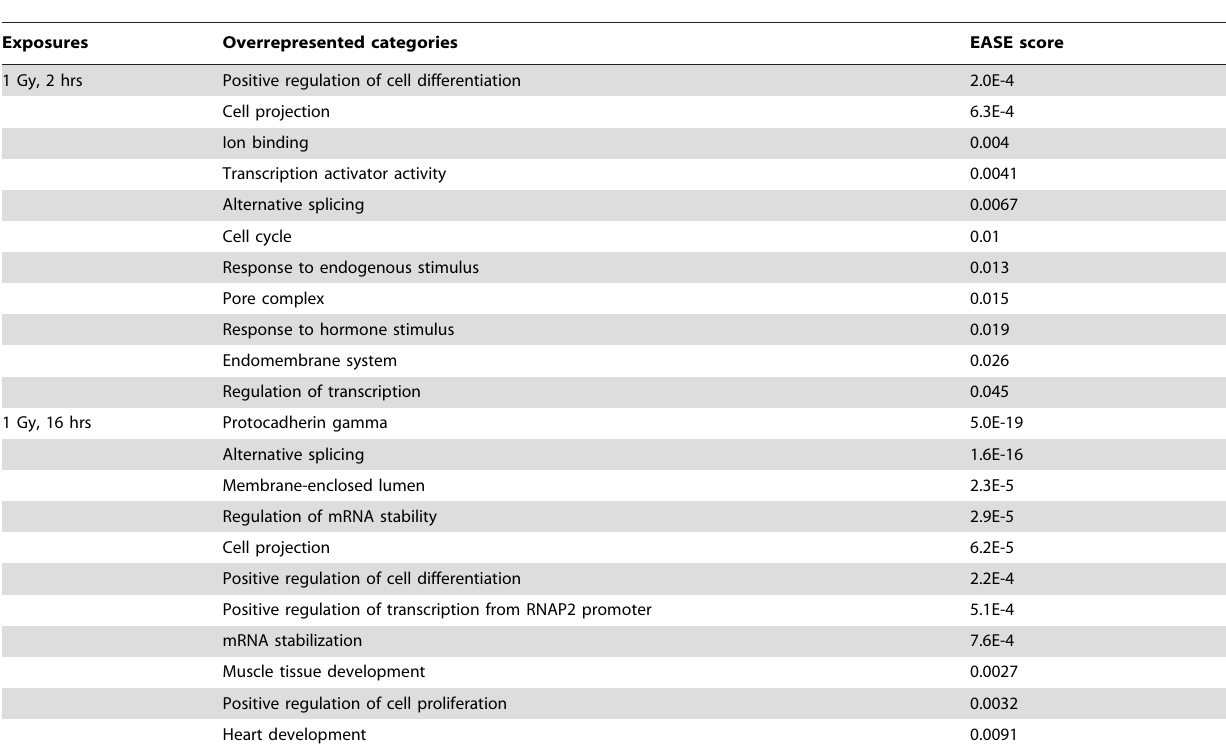
Table 6. Gene Ontology analysis of affected biological themes based on predicted miRNA targets in H1 cell line.